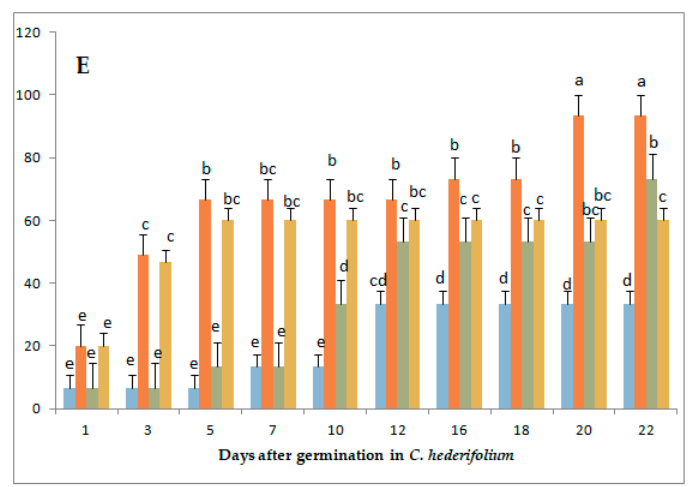
Figure 3. Effect of gibberellic acid (50, 100 and 150 mg/L GA 3 ) and short –day exposure on germination percentage/day ± SE of selected Cyclamen species ( A ) Cyclamen africanum (African cyclamen); ( B ) Cyclamen cyprium (Cyprus cyclamen); ( C ) Cyclamen mirabile (sowbread); ( D ) Cyclamen pseudibericum (false Iberian Cyclamen); ( E ) Cyclamen hederifolium ‘Alba’ (ivy-leaved cyclamen). Values (mean ± SE) followed by different letters are significantly different based on Tukey’s HSD test at p < 0.05.